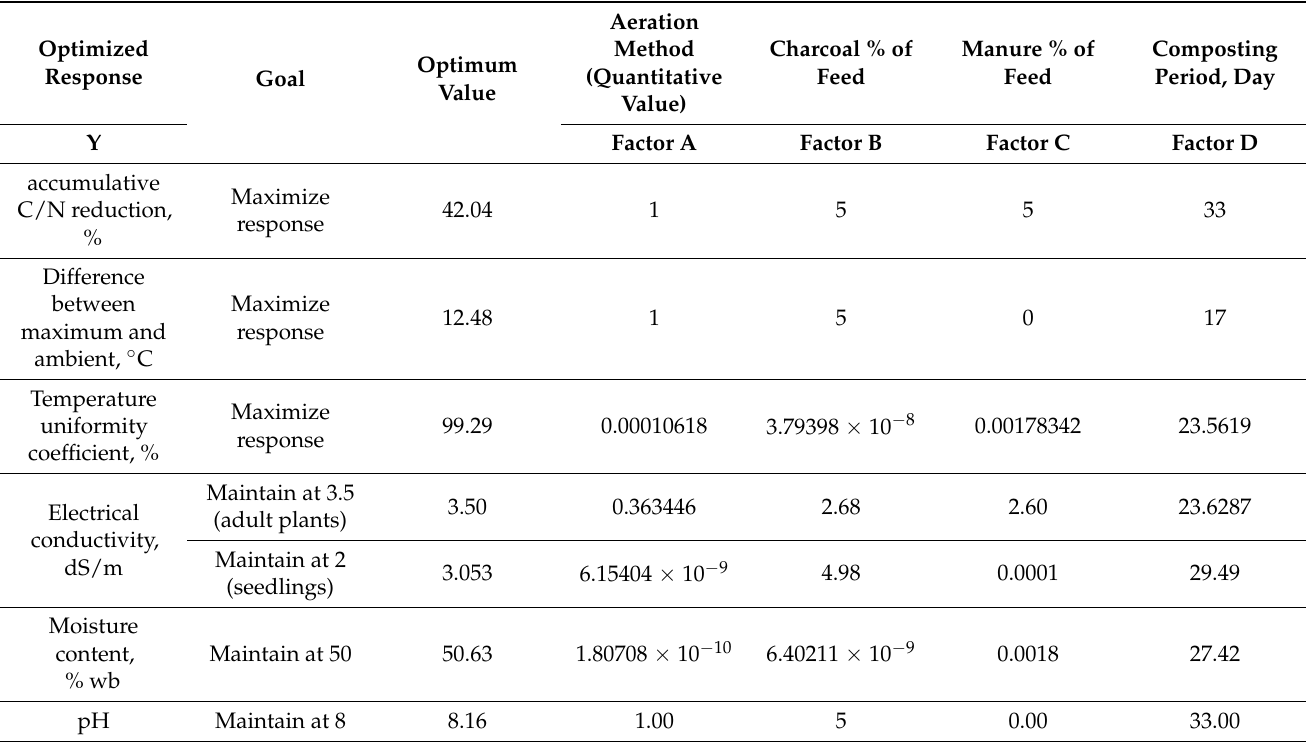
Table 8. Optimized response according to optimization goal and the combination of factors levels to achieve